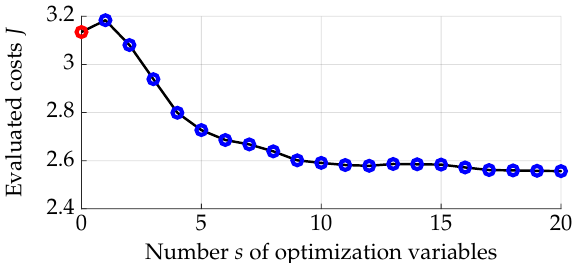
Figure 9. The trajectory costs over the number of parameters are shown. The red circle corresponds to the polynomial trajectory and the blue circles to the optimized motions. Although there is a fast cost function decrease for a low number of parameters, the costs oscillate and slightly increase for more than 10 optimization